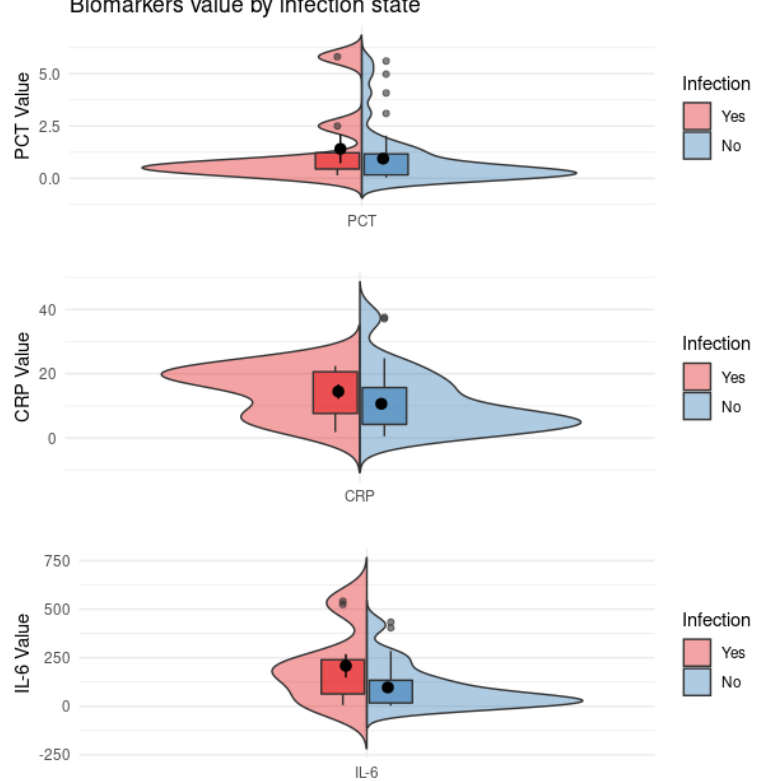
Figure 1. The plot presents the distribution for the three biomarkers under different conditions for both group 1 and group 2. Top : PCT value distribution; middle : CRP value distribution; bottom : IL − 6 value distribution.